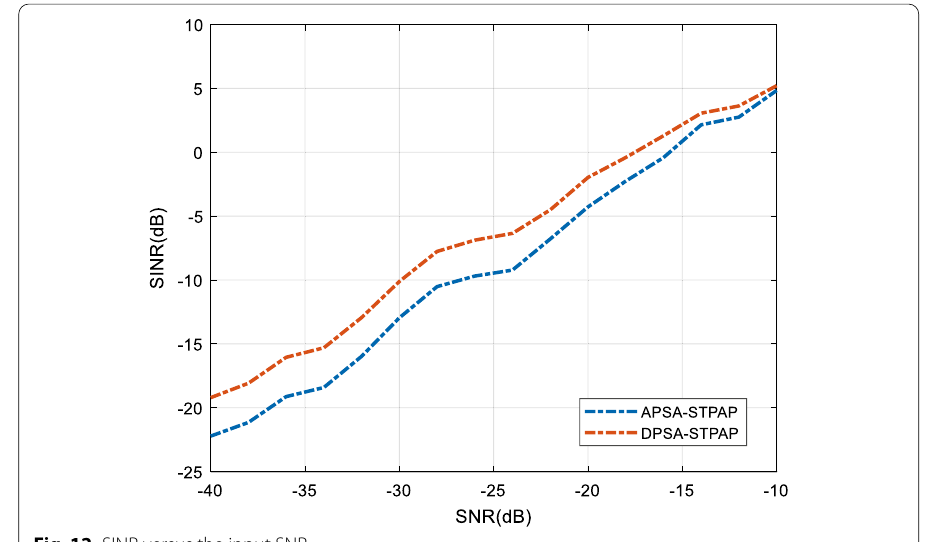
Fig. 12 SINR versus the input